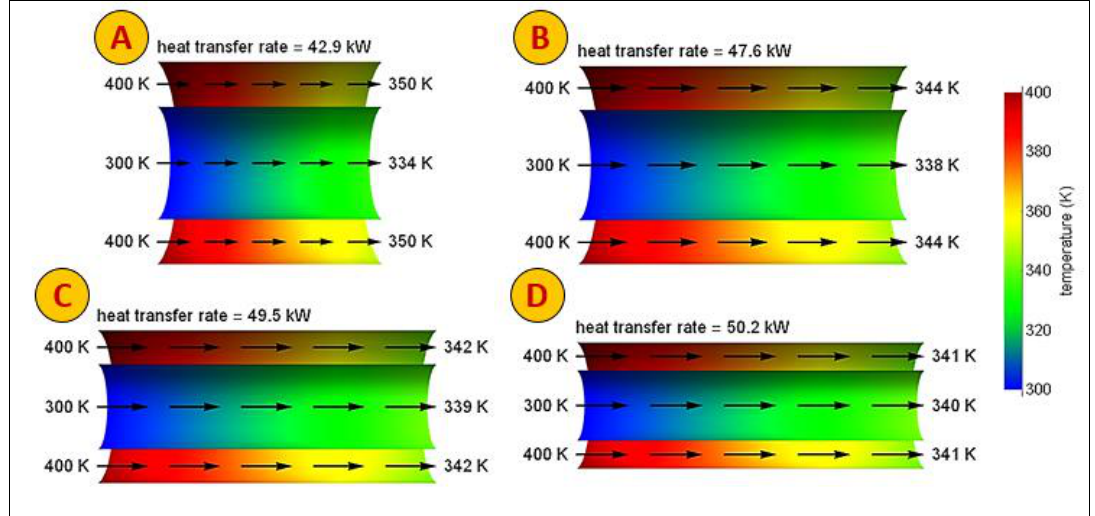
Figure 4. Parallel HE with length of (A), 10 m (B), 15 m (C), 20 m and (D) 25 m